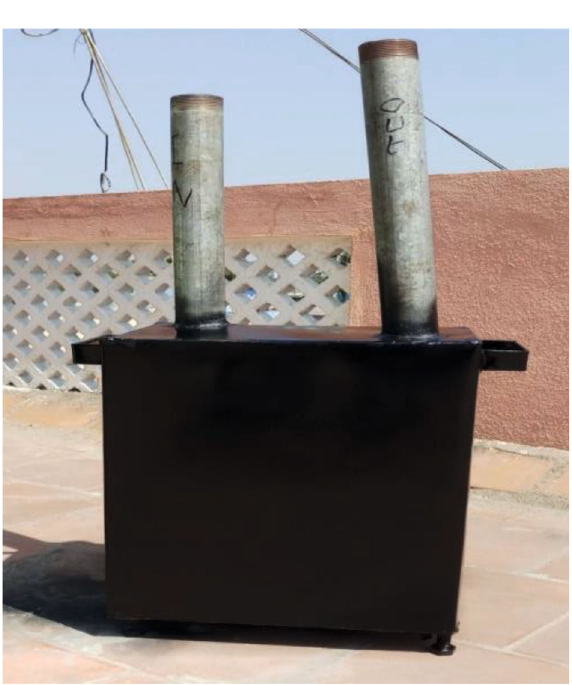
Figure 4: Fabricated photo of developed CO